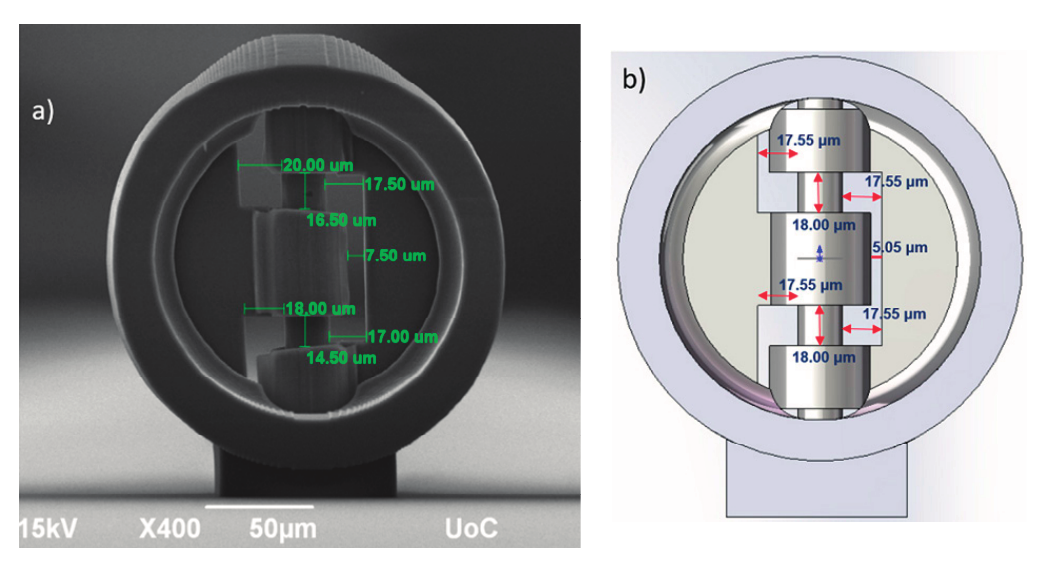
Figure 3. Comparison between SEM image of the fabricated micro-valve and CAD